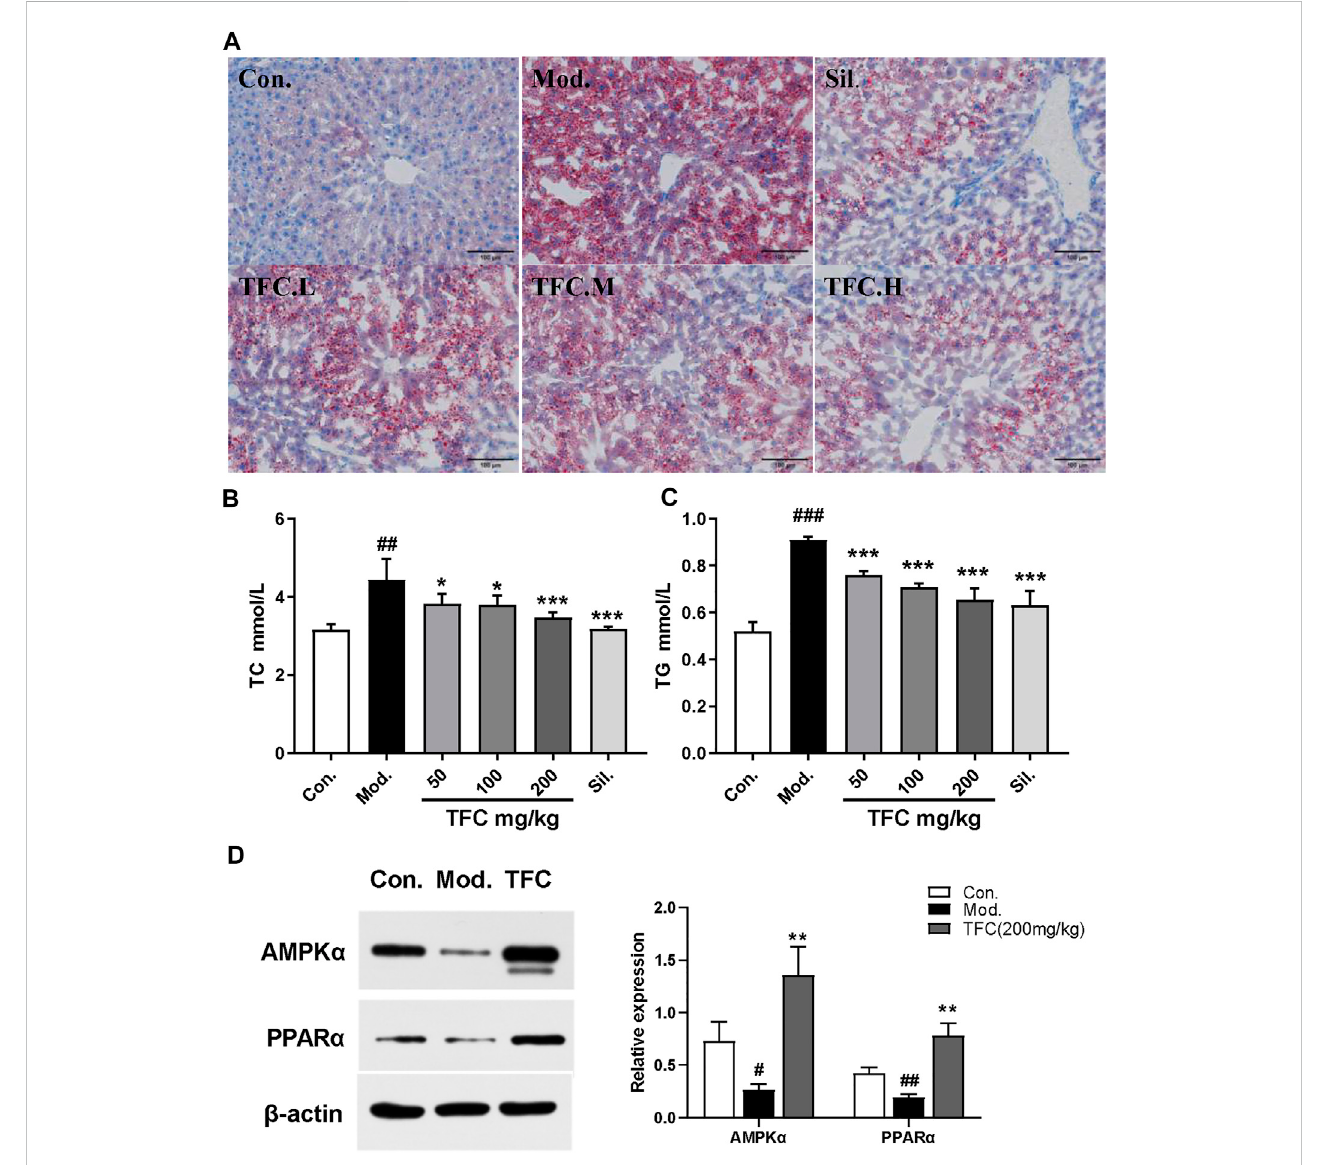
FIGURE 5 TFC suppressed lipogenesis (A) Oil Red O staining showing theaccumulation of fat in the liver (200magni fifi cations) (B) serum level of TC (C) serum level ofTG (D) proteinexpressionofAMPK α andPPAR α intheliver.Dataareexpressedasmean±S.D. # p < 0.05, ## p < 0.01, ### p < 0.001vs.controlgroup;* p < 0.05, **p < 0.01, ***p < 0.001vs. model